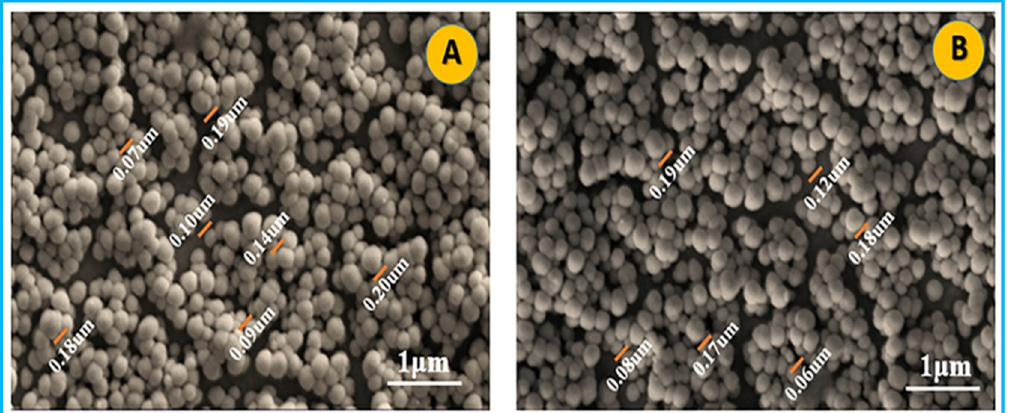
Figure 1. Average hydrodynamic size of NPZRO.